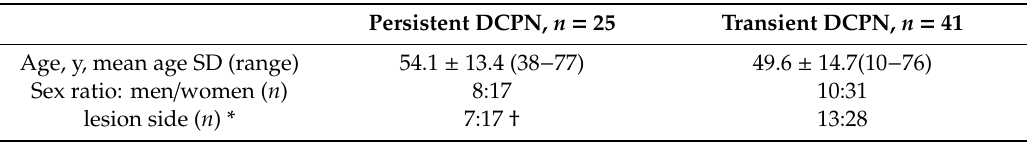
Table 1. Demographic findings between persistent and transient geotropic DCPN (direction-changing positional nystagmus).